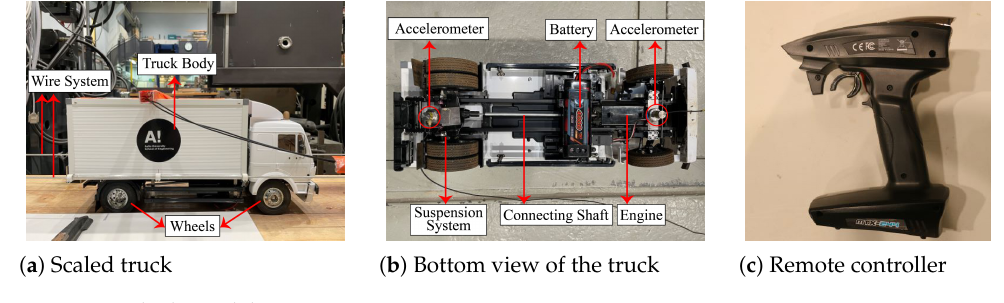
Figure 4. Vehicle